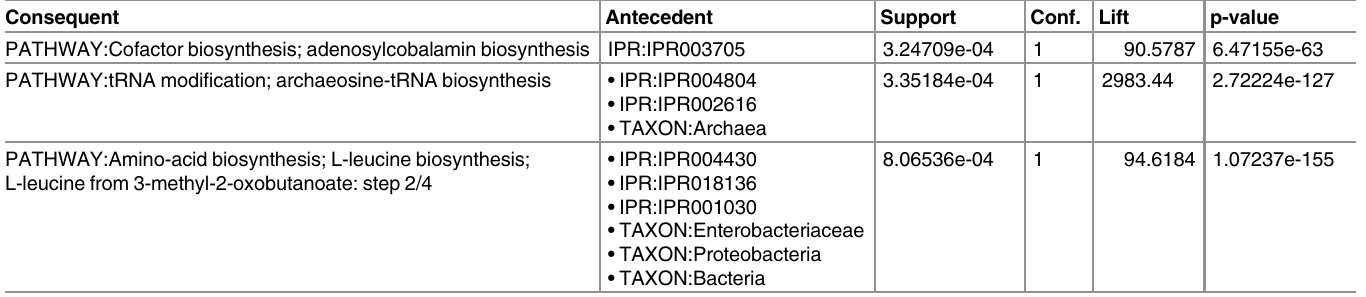
Table 5. Examples of rules generated by Apriori along with their evaluation measures for UniProt/Swiss-Prot prokaryotic entries with manual assertion evidence for pathway annotations. Consequent Antecedent Support Conf. Lift